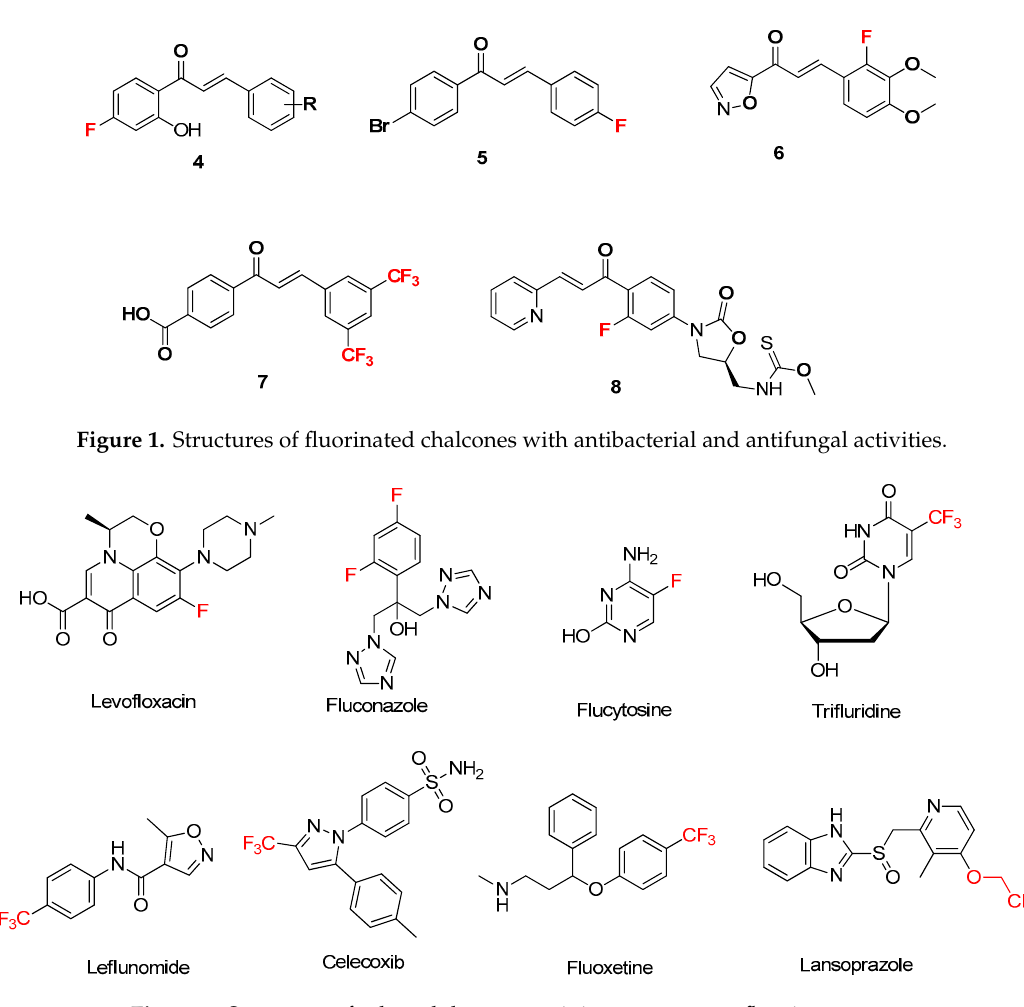
Figure 1. Structures of fluorinated chalcones with antibacterial and antifungal activities.